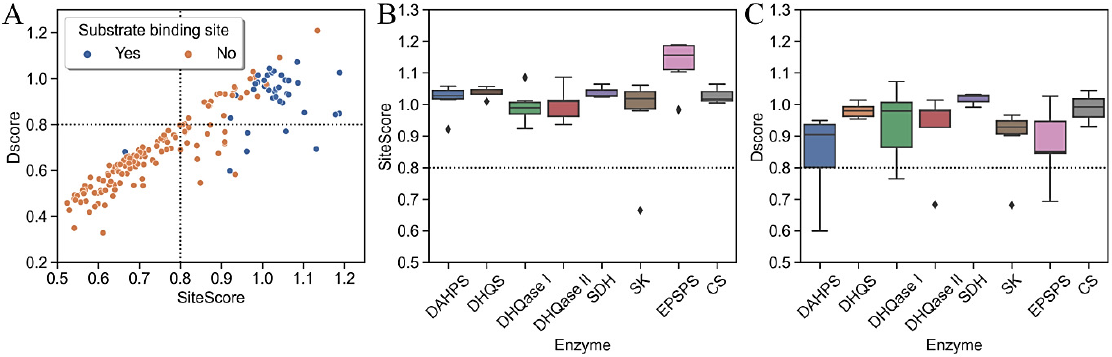
Figure 5. Distribution of ligandability and druggability parameters. ( A ) Scatter plot of DScore versus SiteScore numbers per type of binding site. Two black dotted lines indicate a boundary where both scores are 0.8, dividing the scatterplot into four regions, each with a different potential for druggability and ligation; ( B ) DScores and ( C ) SiteScores of substrate-binding sites per each enzyme in the pathway. Dotted lines in each boxplot indicate a reference value for the average submicromolar site.